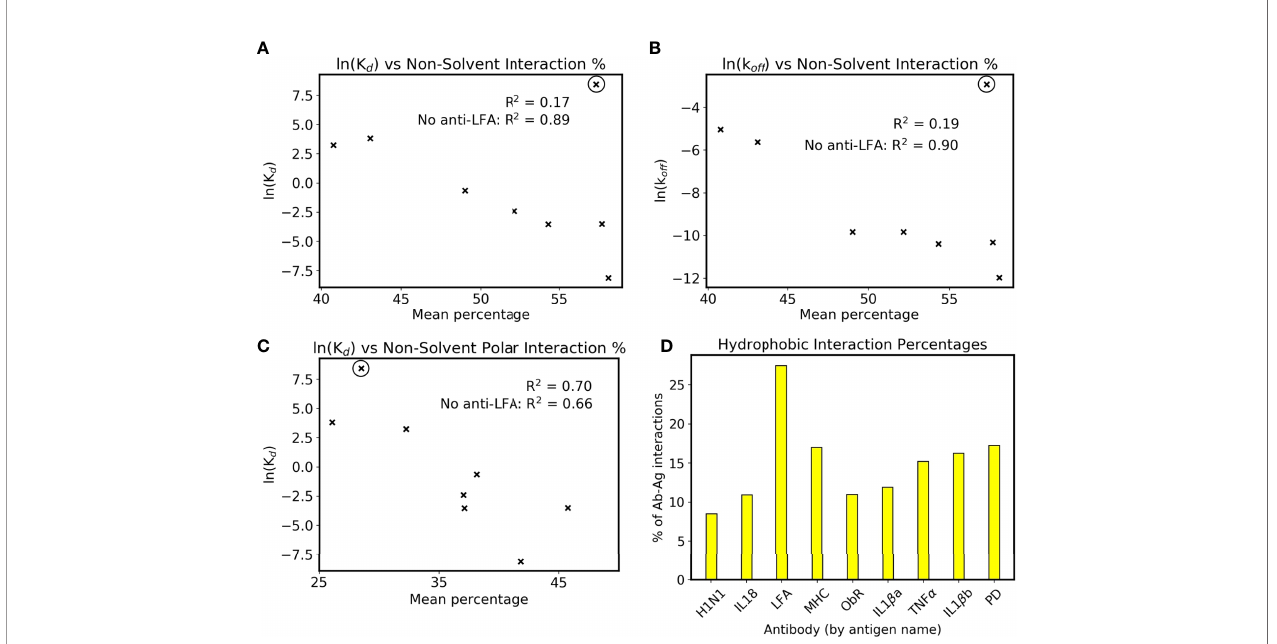
FIGURE 5 | Interactions and af fi nity. The anti-LFA outlier is marked with a black circle, and natural logarithms of K d values in nM are used (see Table 1 ). (A) ln(K d ) and (B) ln(k off ) are plotted against the percentage of intermolecular interactions that are not formed with bulk solvent. (C) ln(K d ) against the percentage of intermolecular interactions that are neither bulk solvent nor hydrophobic contacts. (D) Mean percentage of intermolecular interactions that are hydrophobic in the dataset ’ s simulated holo